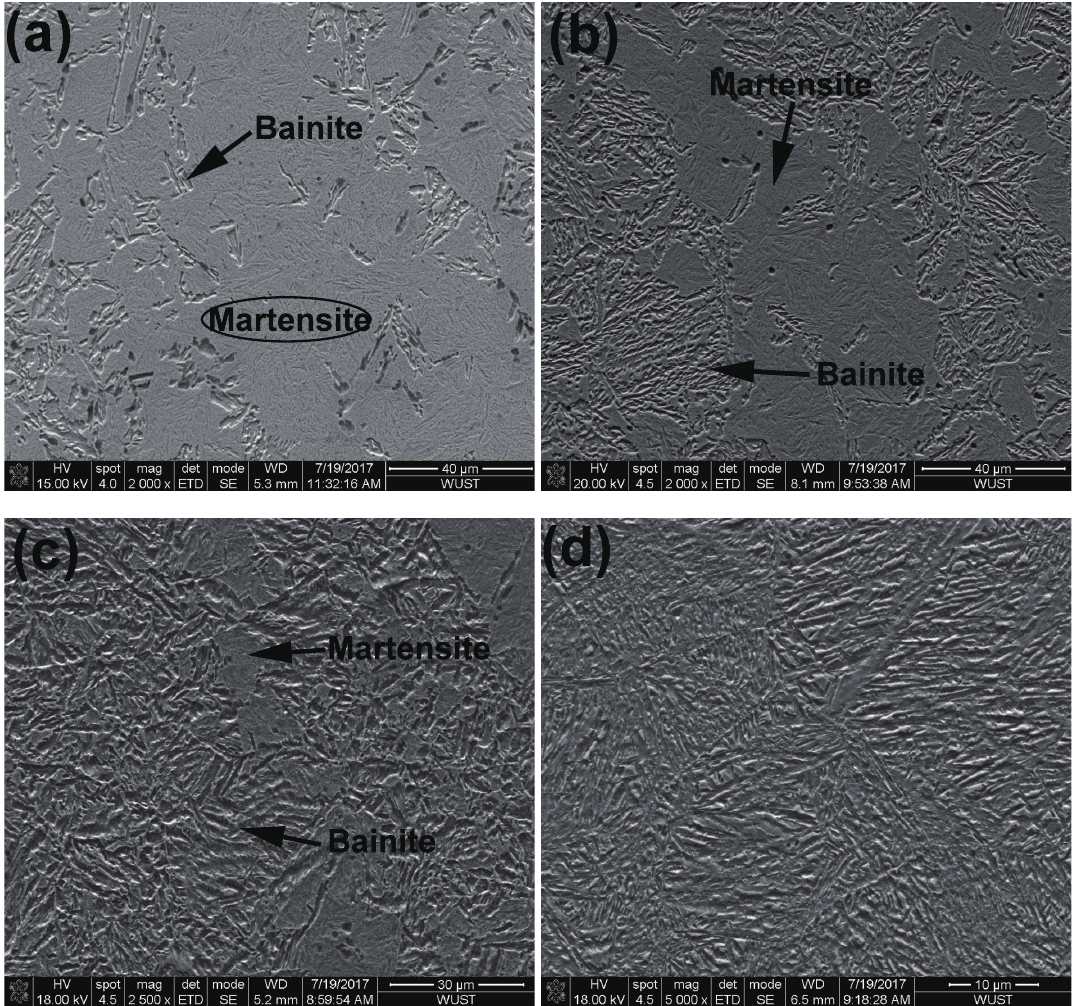
Figure 9. SEM micrographs of nanobainitic steel subjected to the treatments of ( a ) -/450, holding at 450 ◦ C without deformation; ( b ) -/400, holding at 400 ◦ C without deformation; ( c ) 860/350, deformed at 860 ◦ C and followed by isothermal holding at 350 ◦ C; ( d ) 360/300, deformed at 360 ◦ C and followed by isothermal holding at 300 ◦